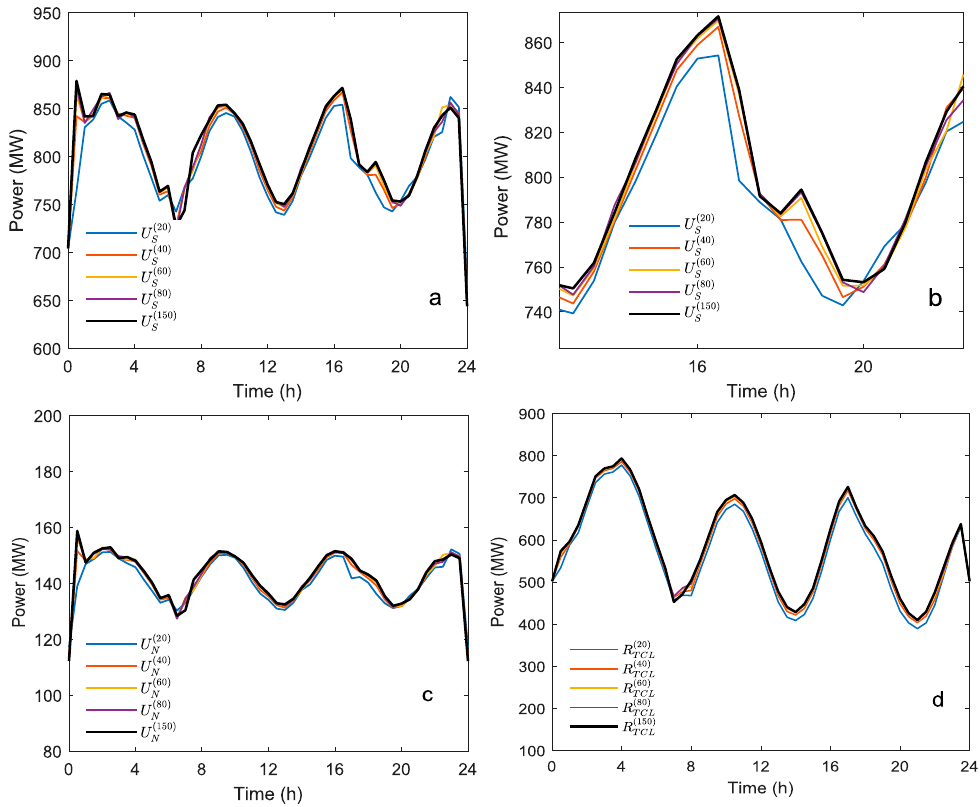
Figure 5. ( a ) Total power consumptions U S ( t ) at di ff erent iterations of the Distributed Coordination Strategy (DCS). ( b ) Zoom of U S ( t ) on a smaller time interval. ( c ) Total power consumptions U N ( t ) at di ff erent iterations of the DCS. ( d ) Total response allocation R ( t ) at di ff erent iterations of the DCS. The iteration number is indicated by the superscript in brackets.